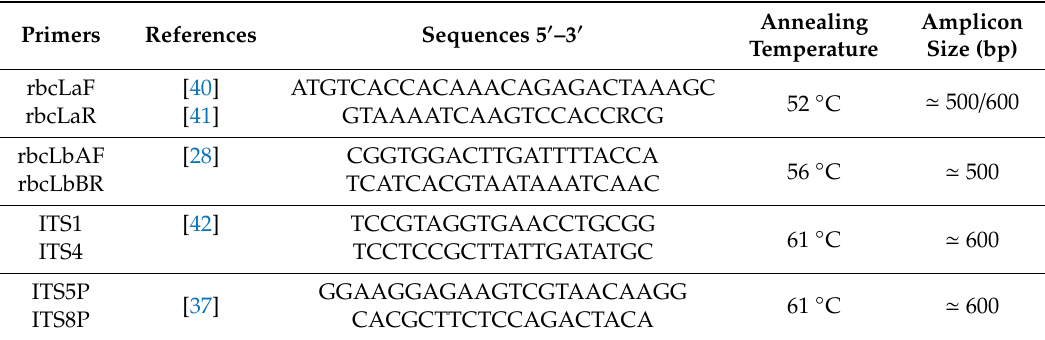
Table 1. List of primers, with relative Ta and predicted band